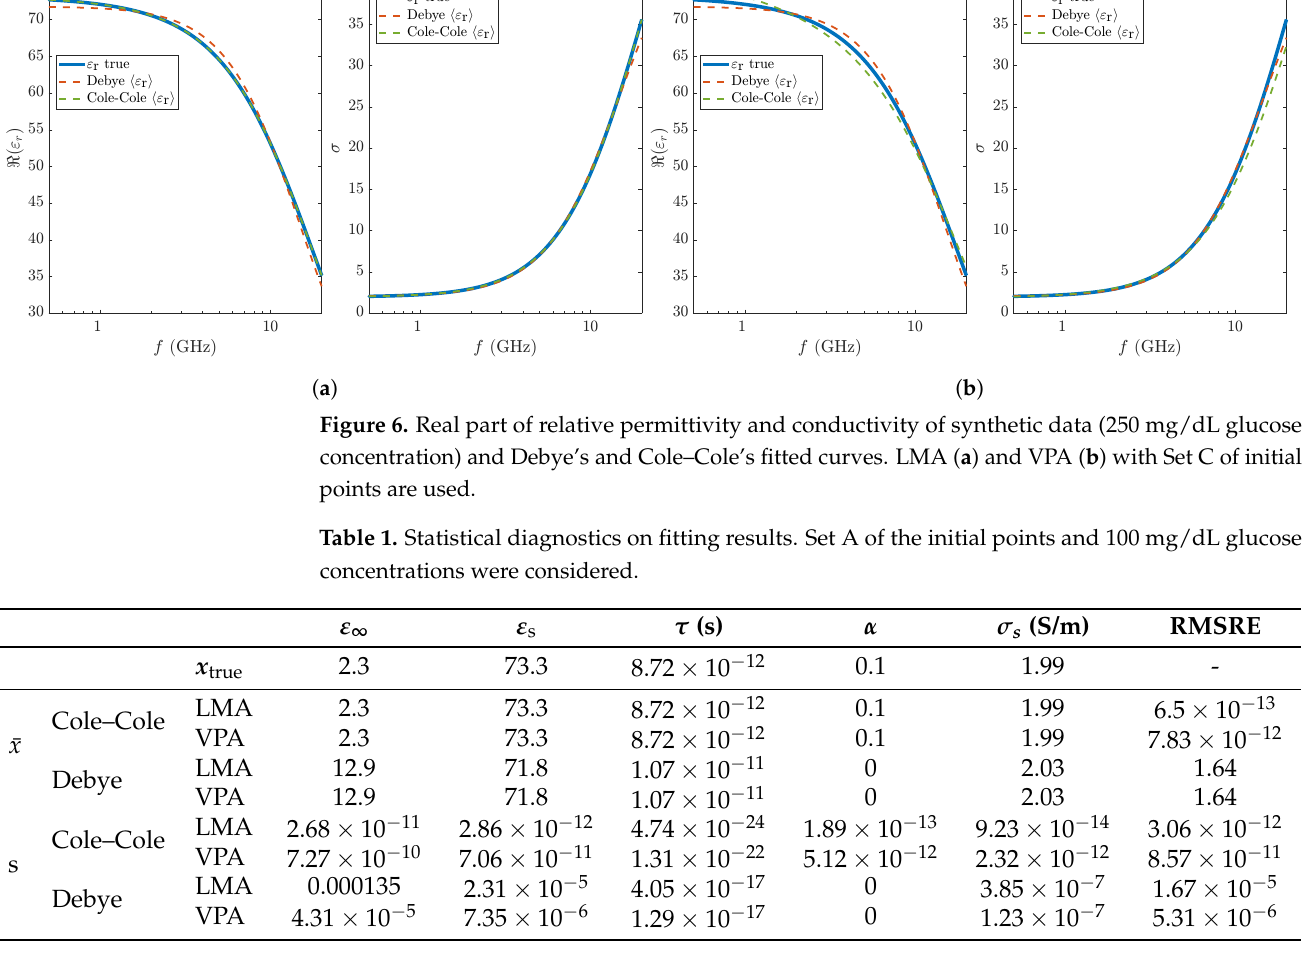
Table 2. Statistical diagnostics on fitting results. Set A of the initial points and 250 mg/dL glucose concentrations were